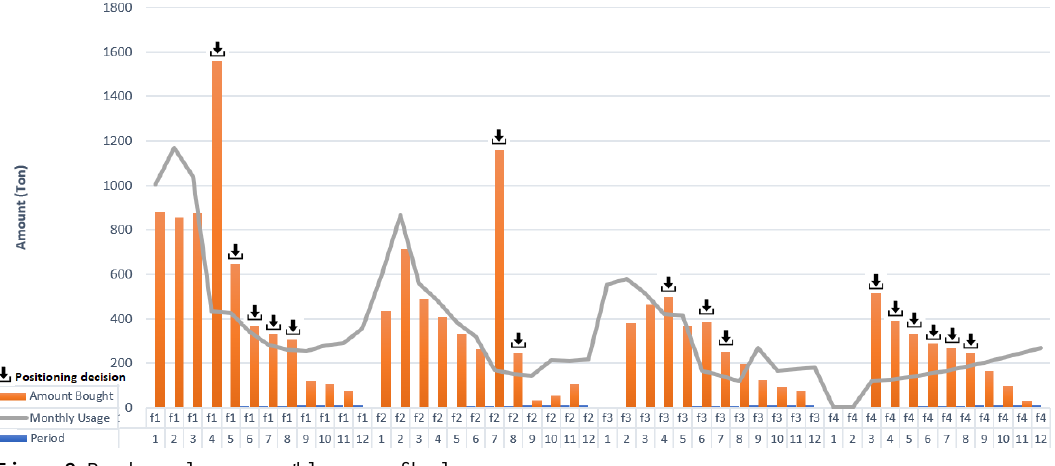
Figure 2. Purchase plan vs. monthly usage of barley